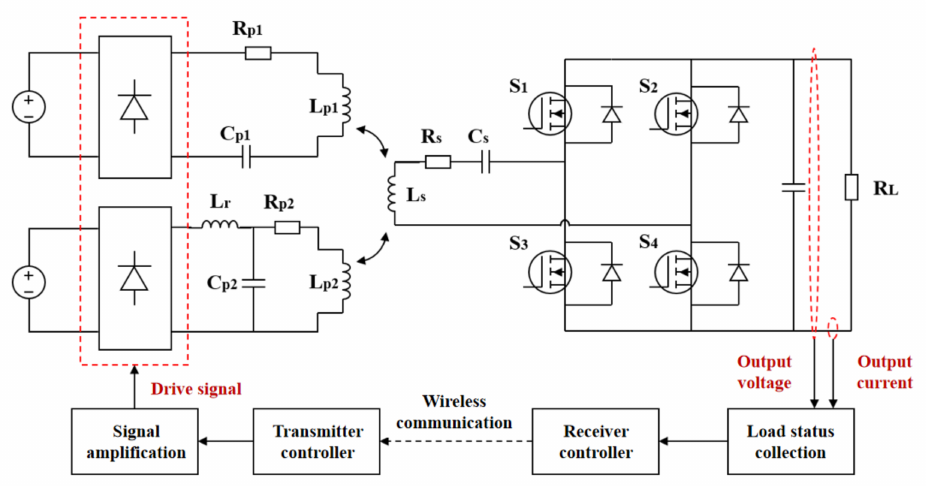
Figure 2. System architecture for a wireless power transfer system with a high voltage transformation